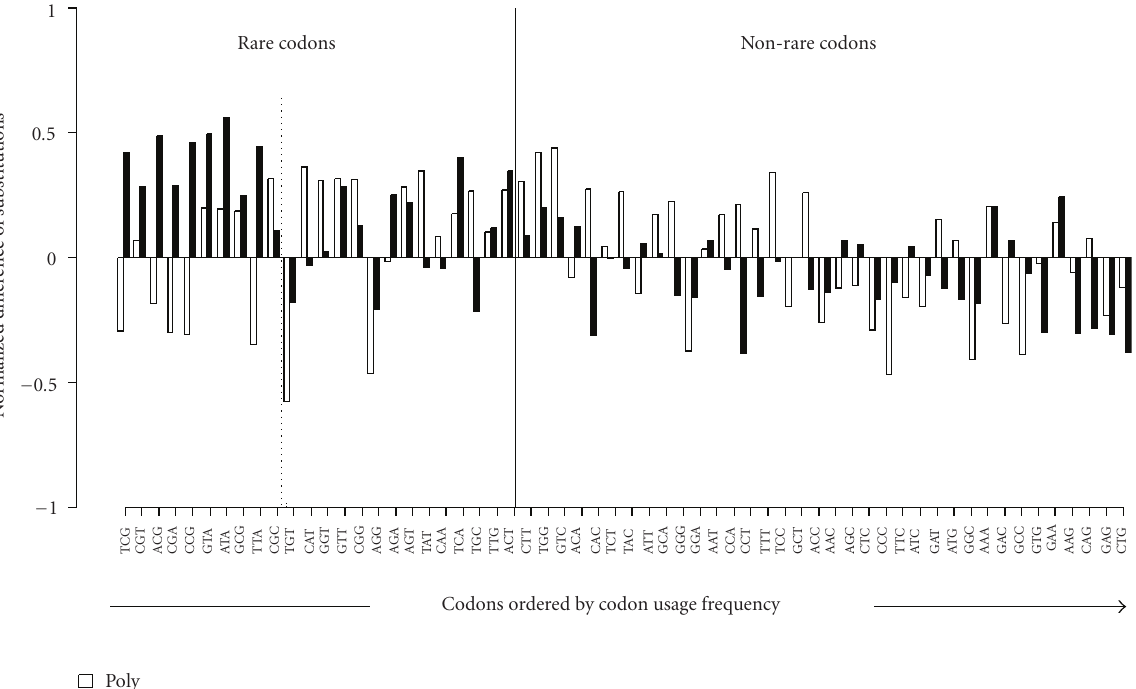
Figure 3: Normalized di ff erence of codon changes (gain and loss) at polymorphic and fixes sites. Codons are ordered in the ascending order of frequencies in human codon usage based on the Codon Usage Database. The solid vertical line separates rare and nonrare codons. The 10 rarest codons are shown in the left side of the dotted